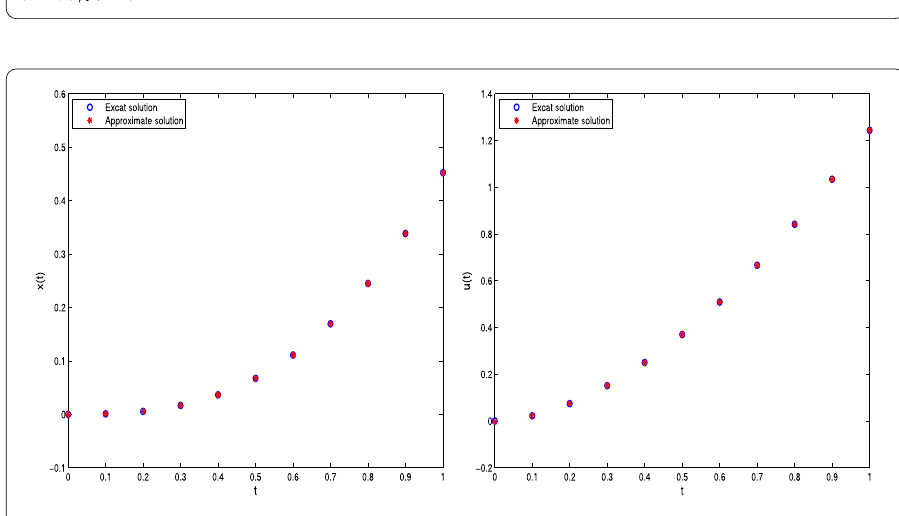
Figure 2 The approximate state x ( t ) (left) and the approximate control u ( t ) (right) at various values of ρ and α = 0.9, N = 3